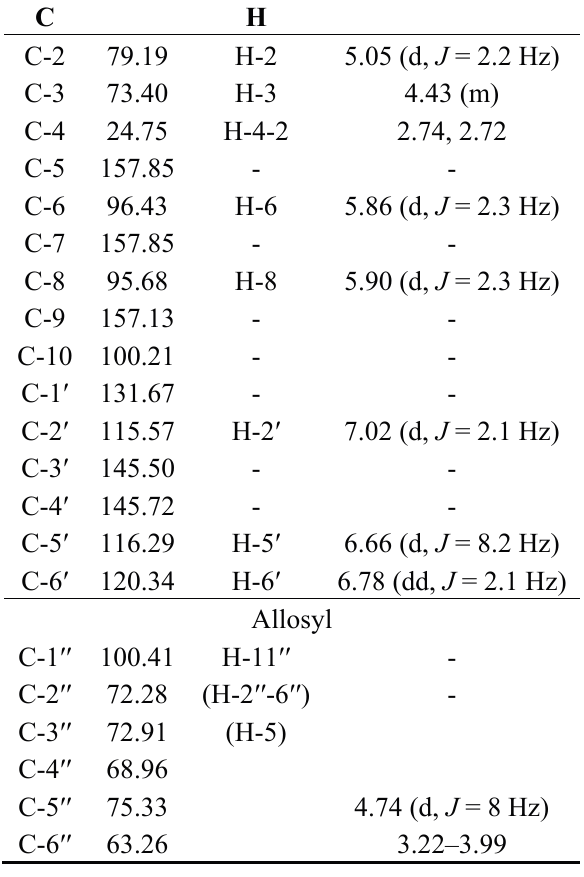
Table 2. The 13 C- and 1 H-NMR spectrum of ( − )-epicatechin-3- O - β - D -allopyranoside